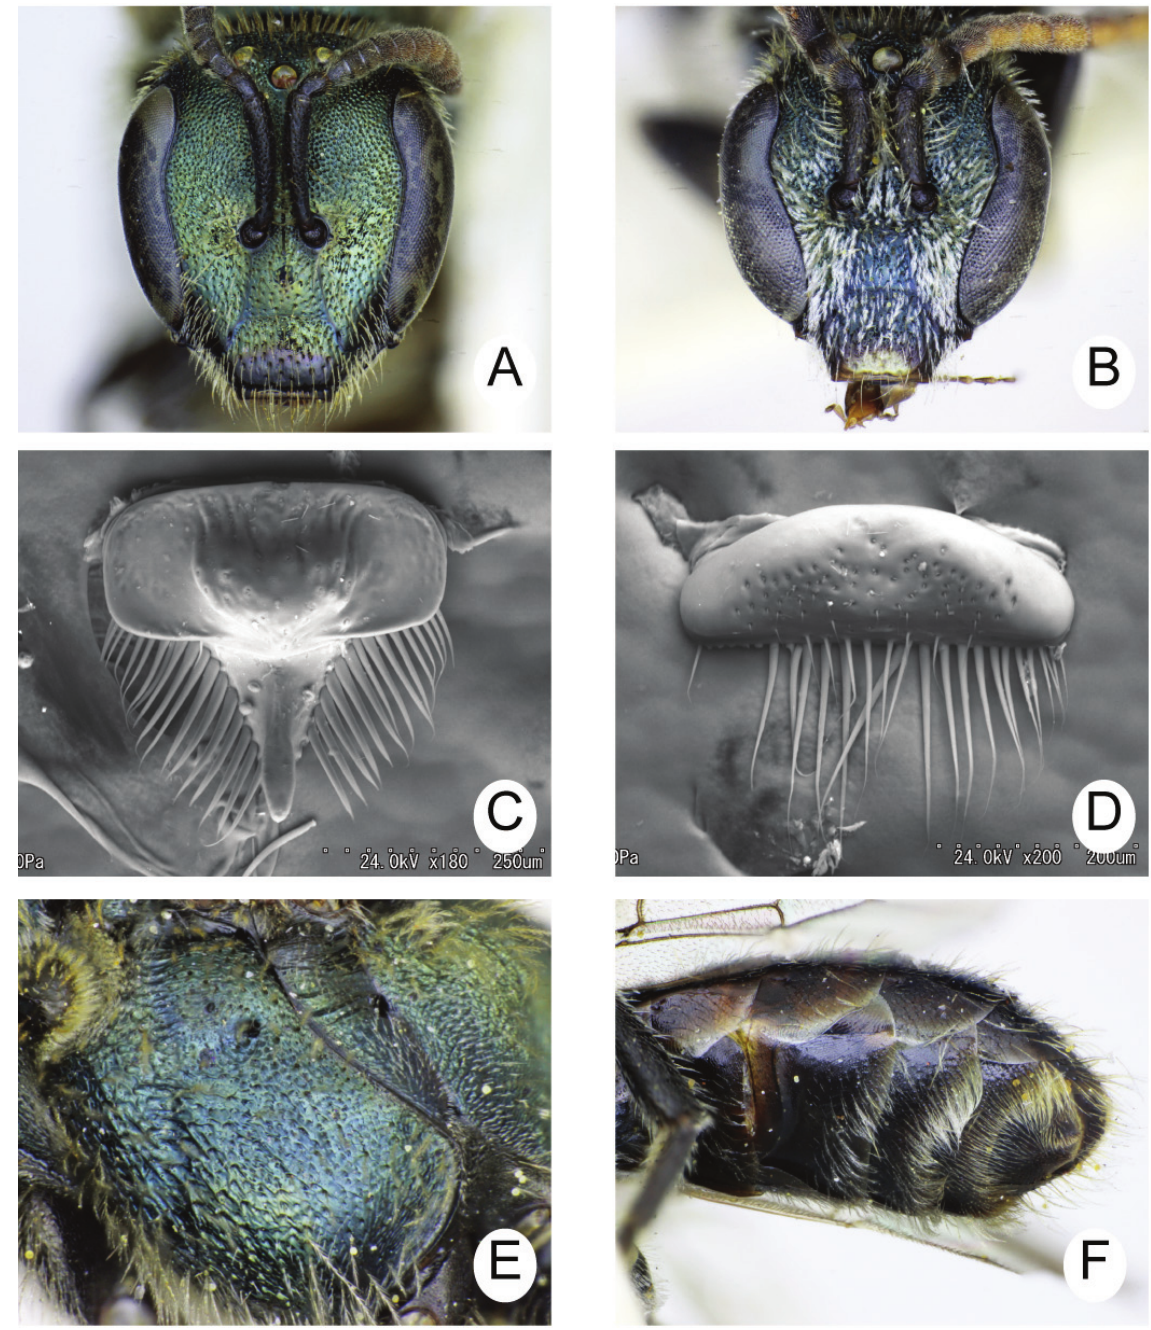
Fig. 20. Lasioglossum ( Dialictus ) ellipticeps (Blüthgen, 1923). A–B . head. C–D . Labrum. E . Mese- pisternum. F . Hairs on metasomal sterna. A, C, E: ♀. B, D, F: